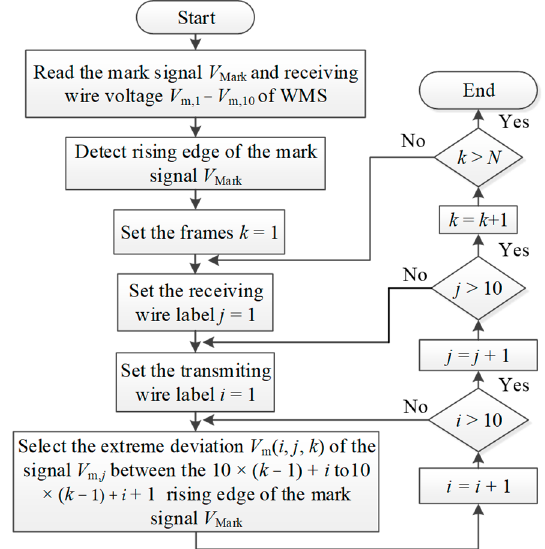
9 of 23 Figure 8. Response signals of the wire ‐ mesh sensor (0°): ( a ) ST; ( b ) D W/O&D O/W. 2.3.2. 3D Flow Visualization